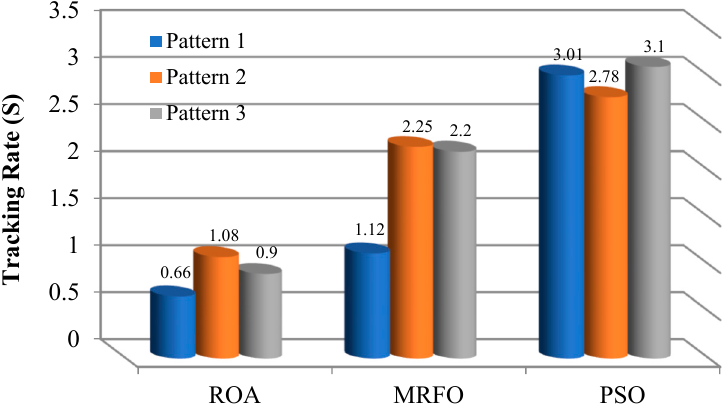
Figure 13. Results comparison in terms of tracking rate for different methods and patterns.